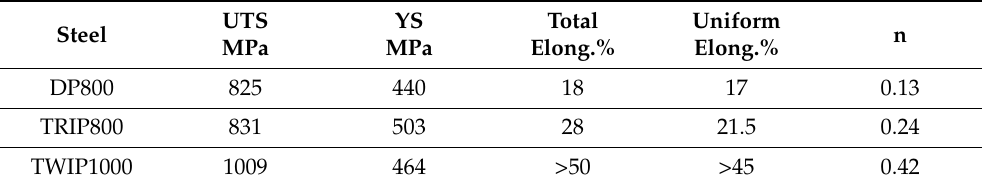
Table 1. A comparison of mechanical properties of typical DP and TRIP steels with the same tensile strength [4] and TWIP 1000 with a higher tensile strength [5].